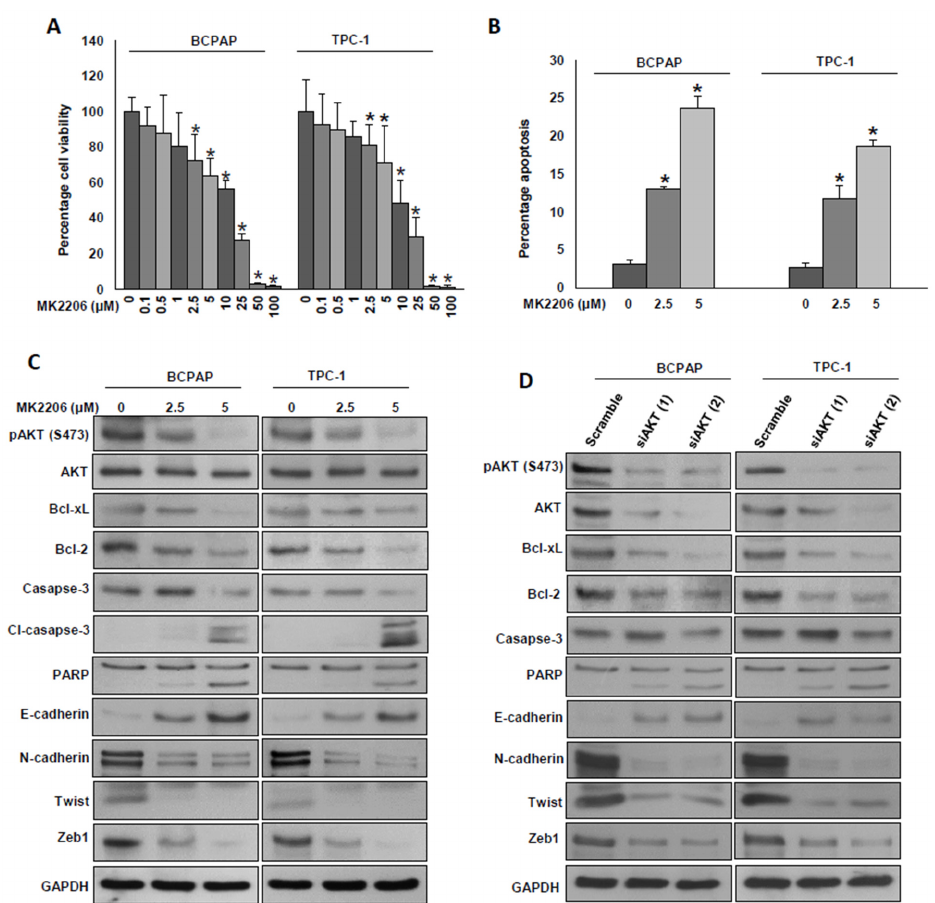
Figure 6. Inhibition of AKT decreases cell growth and attenuates EMT in PTC cells. ( A ) MK2206 induced cell viability loss in PTC cells. PTC cells were incubated with different doses of MK2206 for 48 h, and cell viability was determined by the MTT assay ( n = 6), * p < 0.05. ( B ) MK2206-mediated apoptosis in PTC cells. PTC cells were treated with the indicated doses of MK2206 for 48 h, were subsequently stained with fluorescein-conjugated annexin-V and propidium iodide, and analyzed by flow cytometry. Data presented by the bar graphs are the mean ± SD of three independent experiments ( n = 3). * Indicates a statistically significant difference compared with control, with p < 0.05. ( C , D ) Inhibition of AKT reduced the markers of cell growth and EMT in PTC cells. PTC cells were treated with the indicated doses of MK2206 or transfected two different AKT siRNAs (100 nM) for 48 h. Cells were lysed, and equal amounts of proteins were immunoblotted with antibodies against pAKT, AKT, Bcl-2, Bcl-xL, caspase-3, cleaved caspase-3, PARP, E-cadherin, N-cadherin, Twist, Zeb1, and GAPDH ( n = 3).